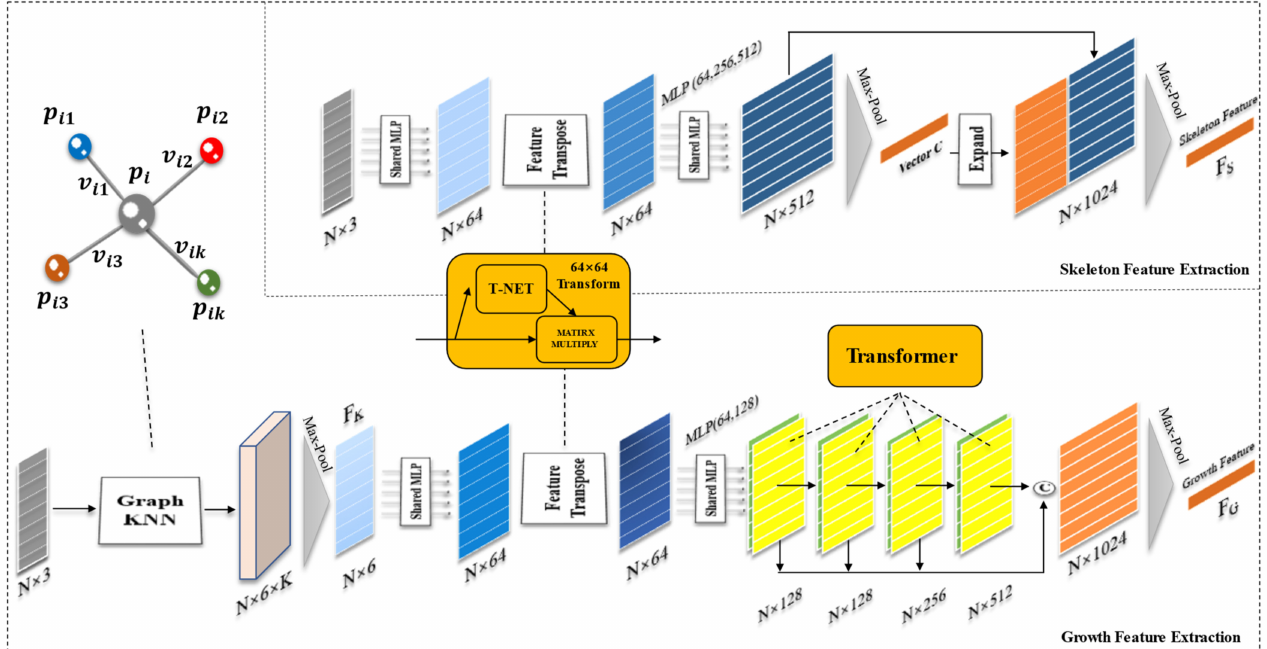
Figure 2. The structure of the composite encoder, including the skeleton point cloud feature extraction module and the dense point cloud feature extraction module. It converts the input incomplete point cloud to feature vectors for three different completion